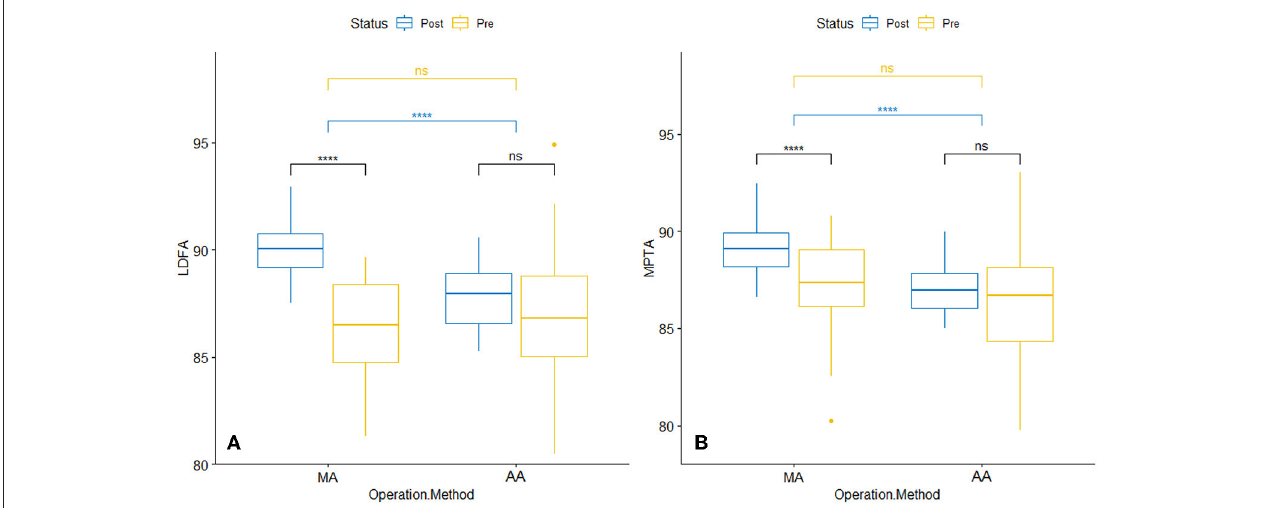
FIGURE 4 | Perioperative radiographic parameters of different surgical groups. (A) LDFA. (B) MPTA. LDFA, lateral distal femoral angle; MPTA, medial proximal tibia angle; **** p < 0.0001, ns, not